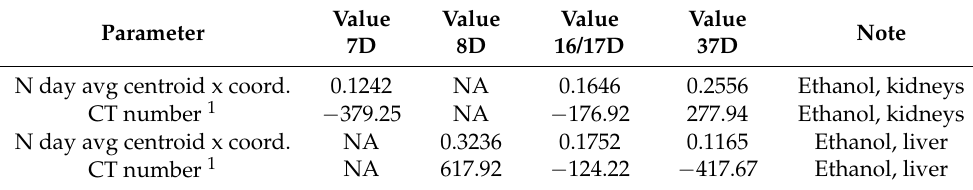
Table 4. Related parameters computed from raw